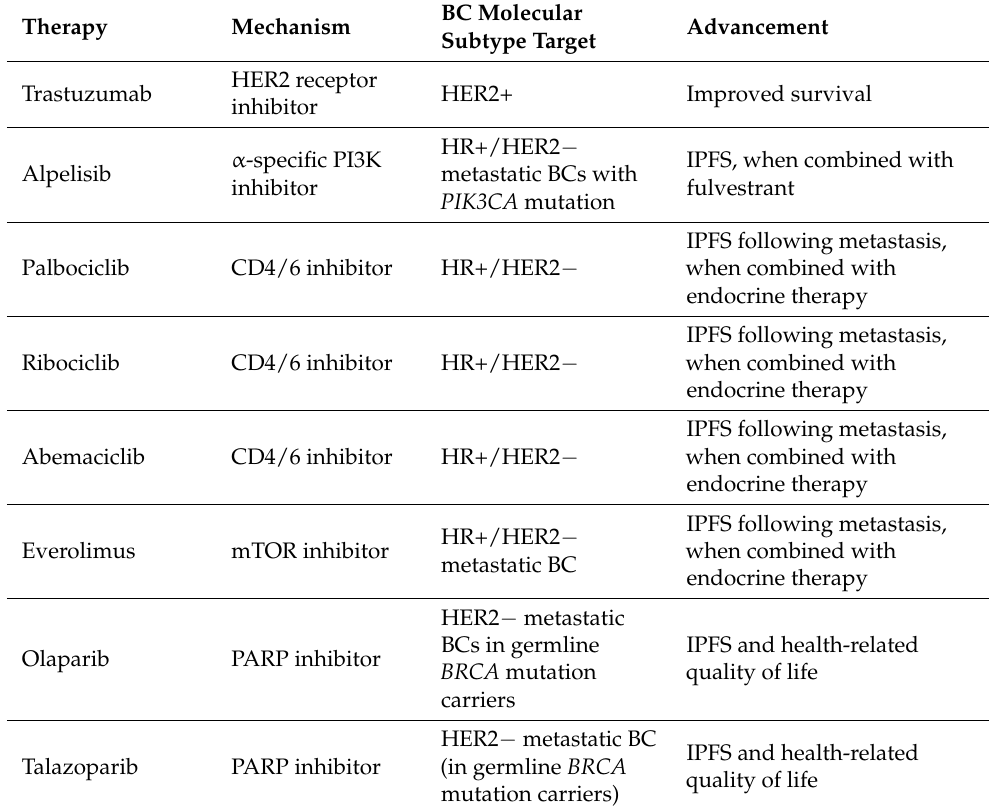
Table 1. Select successful targeted BC therapies, mechanisms, targets, and treatment advancements. References for this table include those provided in the literature